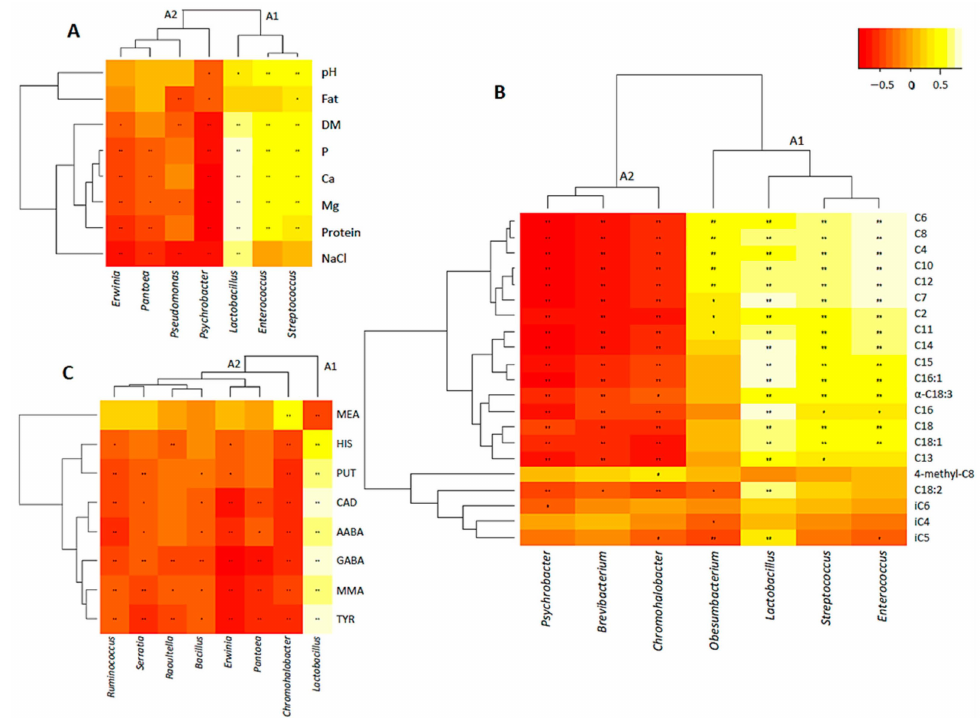
Figure 4. Spearman’s rank correlations with HCA analysis between key bacterial genera and gross composition parameters ( A ), FFAs ( B ) and BAs ( C ). Significant correlations are represented by ** p ≤ 0.01 and * p ≤